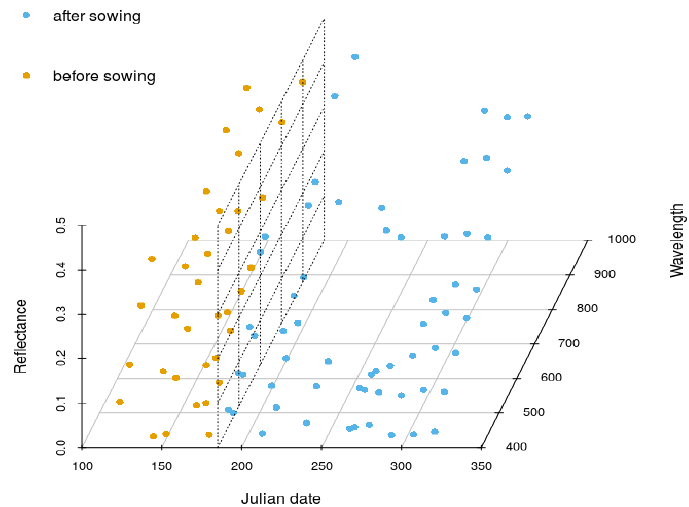
Figure 7. Temporal evolution of the eight-band spectral signature of a single crop. The spectral signatures for the acquisitions before and after sowing are depicted in different colors. The dotted plane parallel to yz represents the concurrent ploughing and sowing date for this field (185 Julian day of the year 2014).